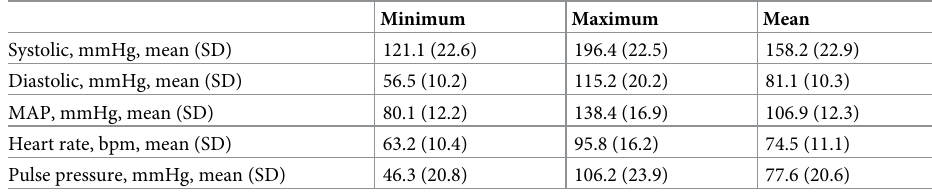
Table 3. Baseline blood pressure values, n =